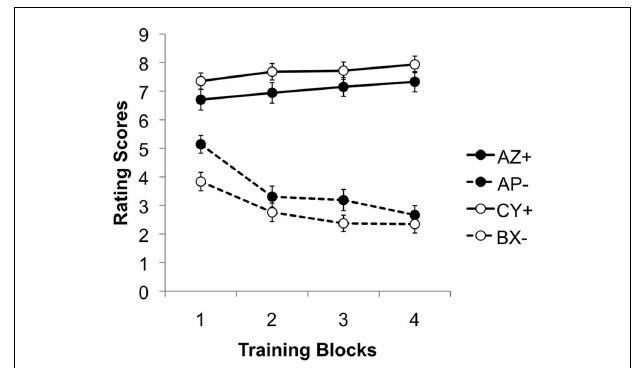
FIGURE 2 | Mean rating scores forA + , U − ,V − , and C + during the six training blocks of the pre-training stage . A rating of 9 reflects expectation of a positive image, 1 of a neutral image, and 5 uncertainty; 95% confidence intervals are presented.